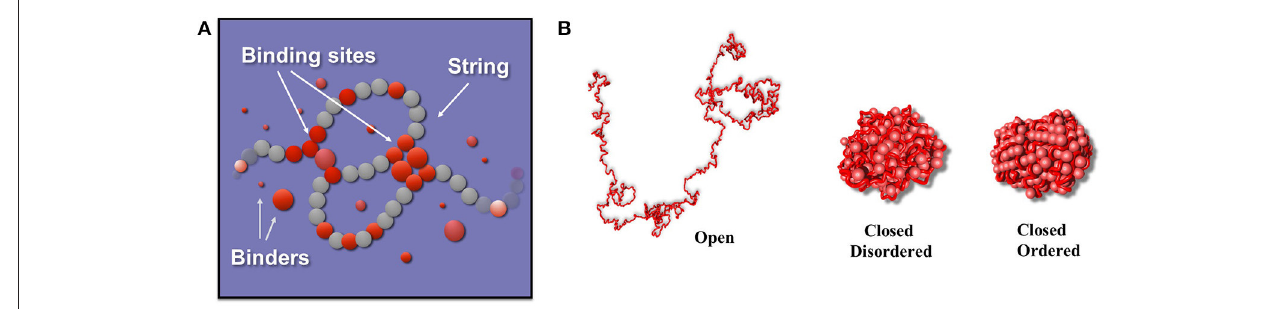
FIGURE 1 | The Strings and Binders model of chromatin. (A) The StringandBinders (SBS) model aims to quantify the scenario where chromatin folding is established by diffusing molecular factors such as Transcription Factors. The figure shows a toy version of the model including only one type of binders (red spheres): c is the binder concentration and E X their binding affinity. (B) Such a simple toy model has three main stable conformational classes (images adapted from Chiariello et al., 2016): a coil state where the polymer conformation is an open Self-Avoiding Walk (SAW) chain randomly folded (polymer on the left); a disordered globule state where the polymer is closed in a compact, disordered conformation (center) and an ordered globule state where the polymer and the binders are in an ordered, crystalline-like, conformation (right).